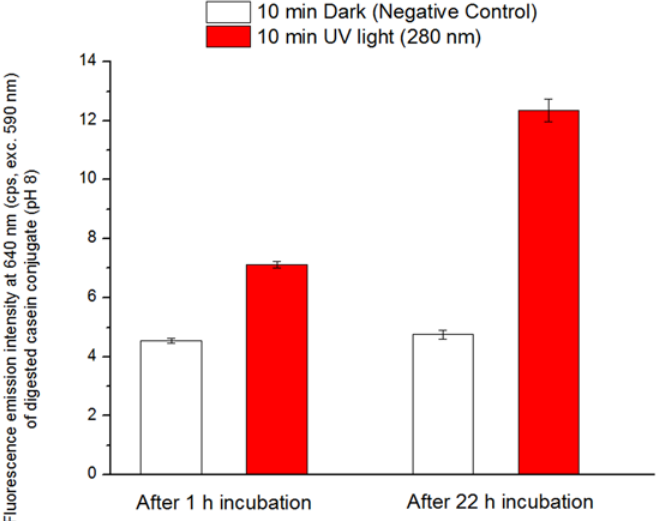
Fig 14. Fluorescence signal presented by the digested substrate for plasminogen kept in the dark (10 min in the dark, negative control) and UV illuminated plasminogen (10 min 280 nm illumination). Fluorescence signal is used as a measure of degradation of the substrate and to acess plasmin activity. The fluorescence readings were performed after 1 hour and 22 hours which is standard procedure for the used Casein-based substrate. The background fluorescence signal from substrate blank was